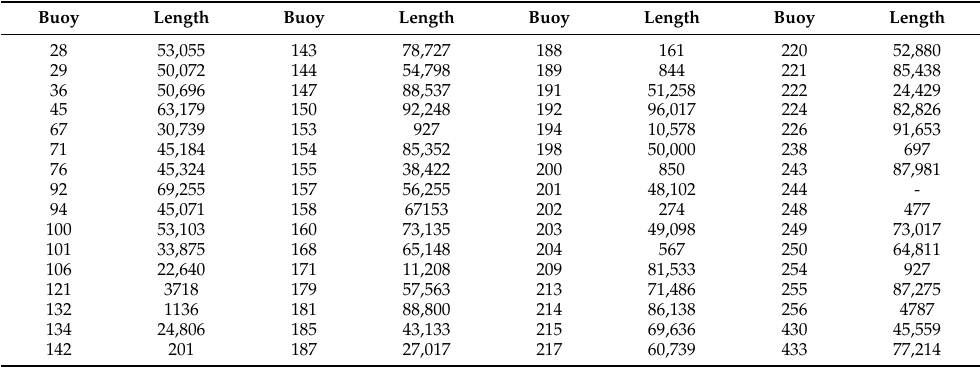
Table 4. Length of the 64 studied wave height time series after preprocessing the corresponding surface elevations. The buoy with no associated value corresponds to that in which the surface elevations are unobserved.